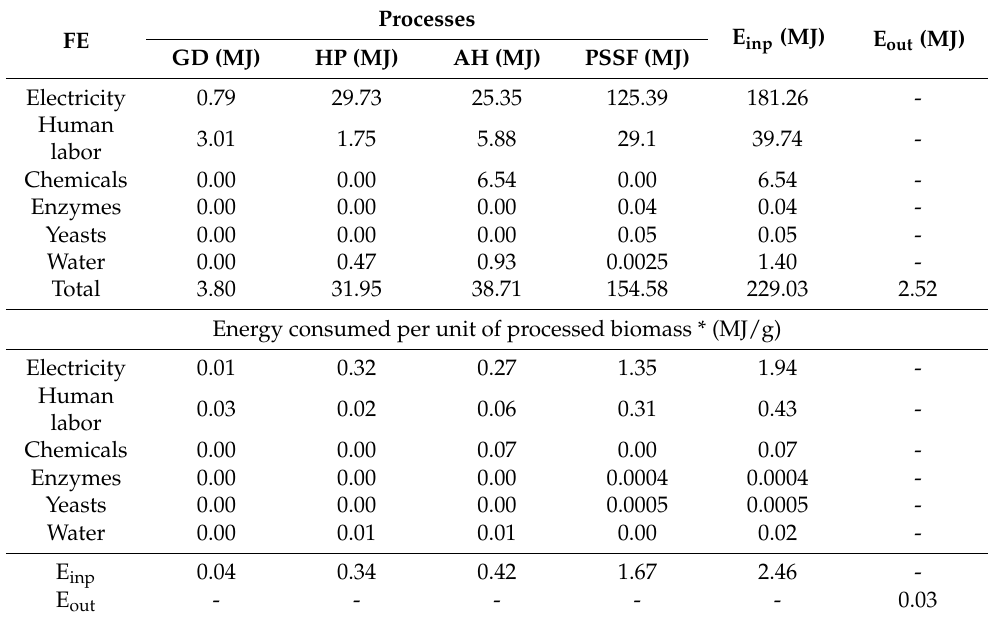
FE = forms of energy; GD = grinding; HP = hydrothermal pretreatment; AH = acid hydrolysis; EH = enzymatic hydrolysis; PSSF = pre-saccharification simultaneous and fermentation; E inp = energy input; E out = energy output; * Processed biomass weight = 93.2